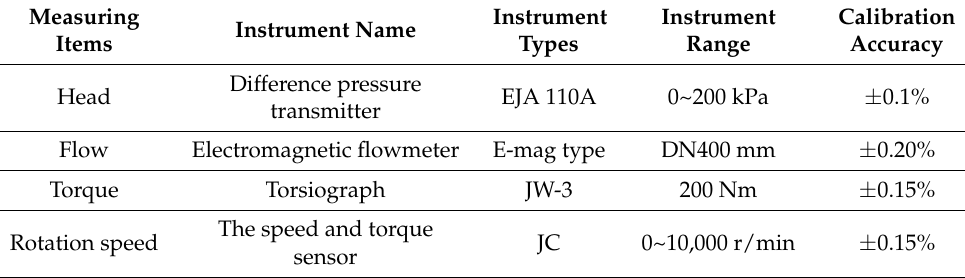
Table 1. Main measuring instruments for energy characteristic experiment.